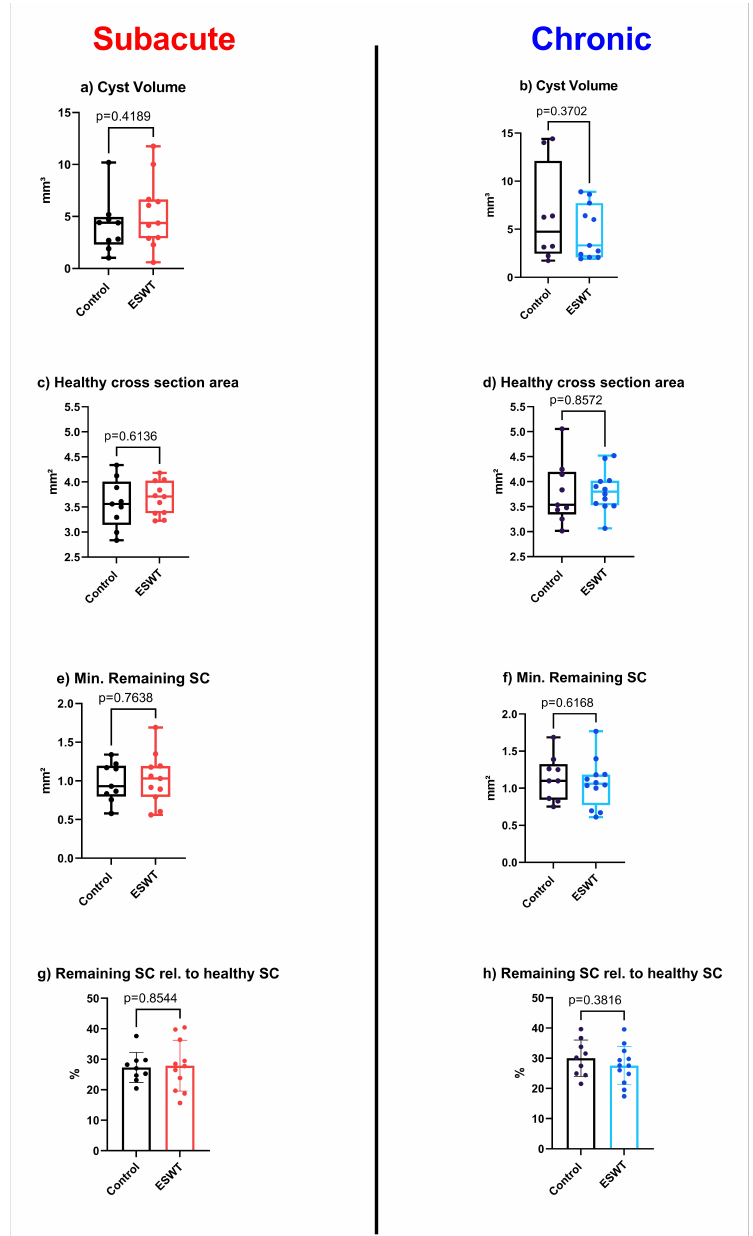
Figure 4. Calculated parameters generated by µ CT-Scans. Various parameters were calculated using an algorithm to explore the potential morphological effects of therapeutic intervention in a subacute (( a , c , e , g ), ESWT group in red and controls in black) as well as chronic (( b , d , f , h ), ESWT group in blue and controls in black) setting. The cystic volume ( a , b ) was determined in clear distinction from a syrinx. Healthy cross-sectional area ( c , d ) was determined distal to the spinal cord defect site, while the minimal remaining spinal cord ( e , f ) was measured as a plane at the maximal diameter of the cystic cavity. Remaining spinal cord relative to healthy spinal cord ( g , h ) was calculated in comparison to the healthy cross section. Cystic volume = total volume of cyst from 5 mm caudal to 5 mm rostral of the defect. Healthy cross section area = average cross-sectional area at a distance of 5–10 mm rostral and caudal of the lesion area of a linear regression of healthy tissue outside the defect area to estimate the healthy cross-sectional area. Minimal remaining spinal cord = smallest remaining cross-sectional area of healthy spinal cord tissue. Remaining spinal cord relative to healthy spinal cord = smallest remaining cross-sectional area of healthy spinal cord tissue as a percentage of the healthy